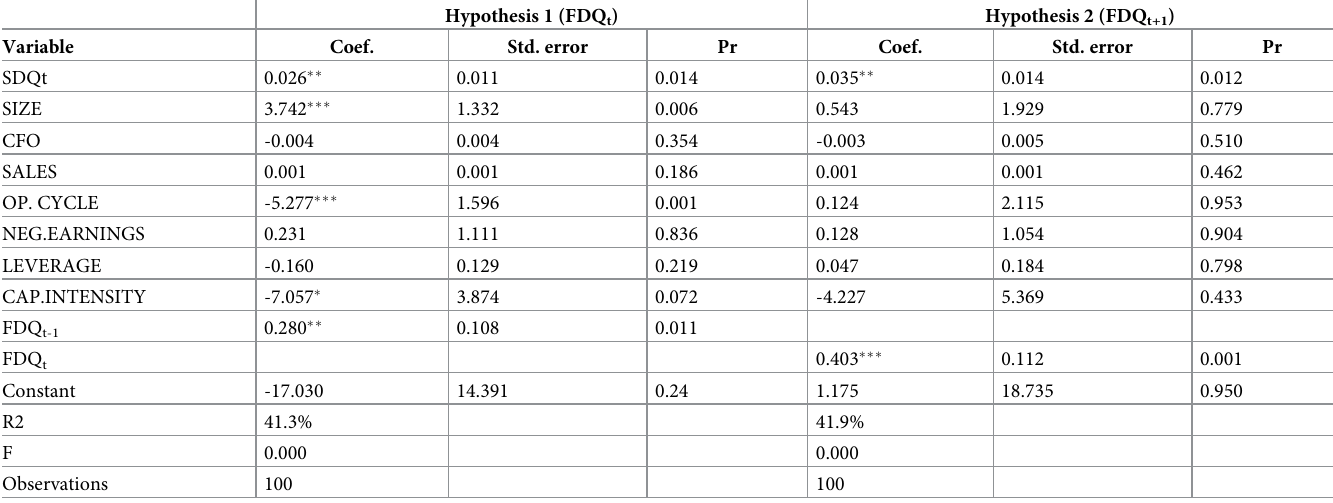
Table 4. Relationship between financial disclosure quality and sustainability disclosure